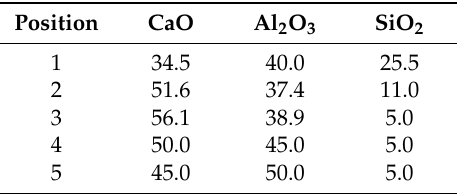
Figure 3. Schematic diagram of smelting separation experimental apparatus (1—argon cylinder;